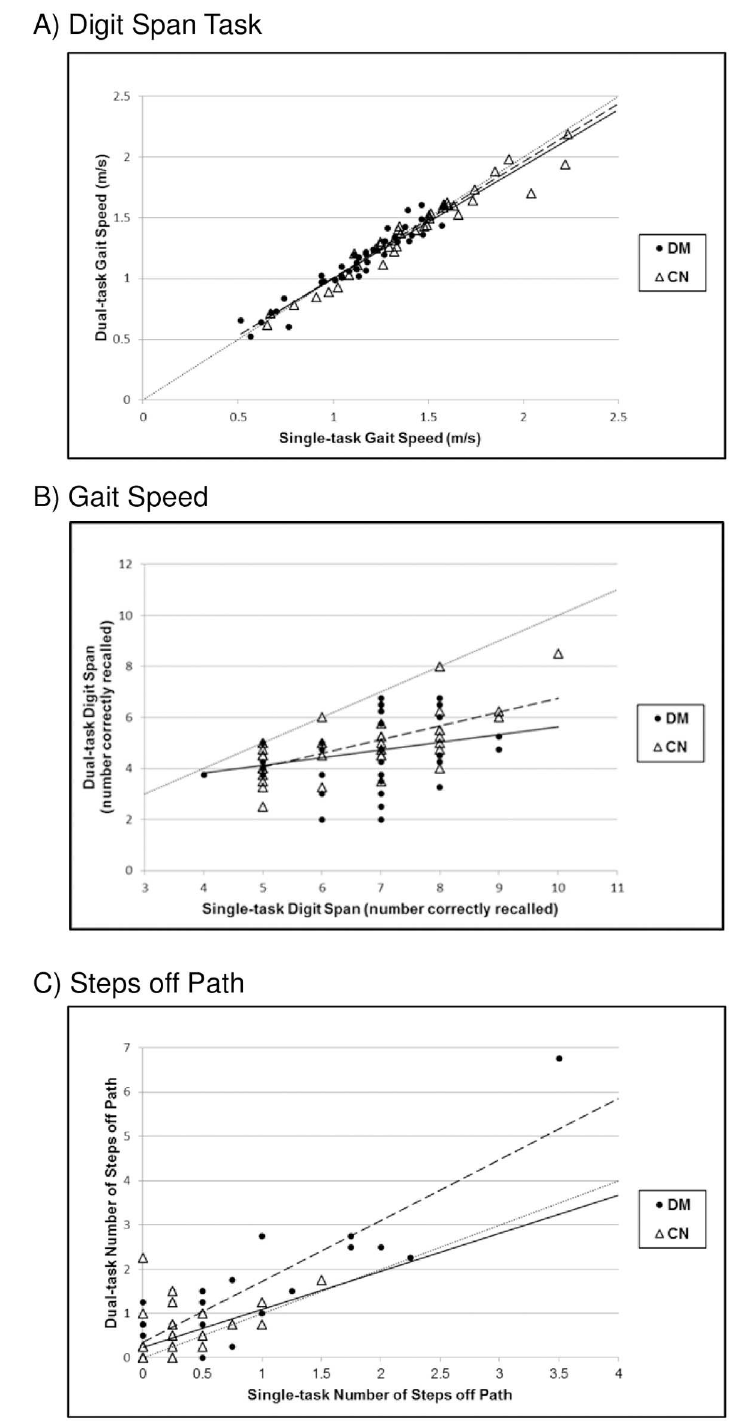
Fig 3. Dual-task costs on the Walking and Remembering Test. (A) Percent changes(e.g. dual-taskcosts) from single- to dual-taskconditionsin digit span performance, (B) gait speed, and (C) steps off path on the Walkingand Remembering Test. Lightlydotted lines represent no changein performance(dual-task cost) from single- to dual-taskconditions. Dashedand solid lines reflect trend lines for the diabetes and comparison groups, respectively.In (A) and (B), points falling belowthe dotted line reflect poorer cognitiveperformance and slower walkingspeedunder dual-task conditions. In (C), points falling abovethe dotted line reflect more steps off path under dual-task